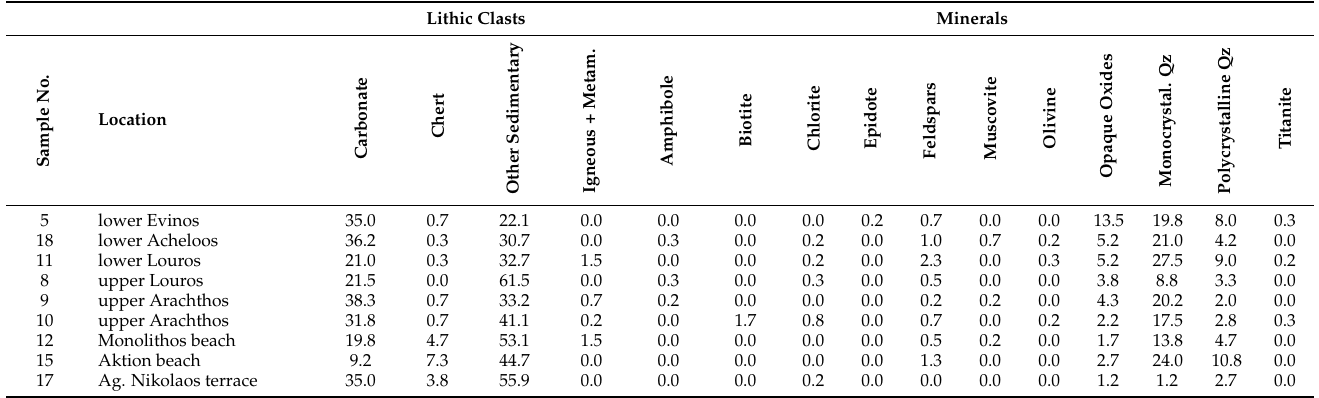
Table 1. Point counting * of thin sections of unprocessed bulk sand samples